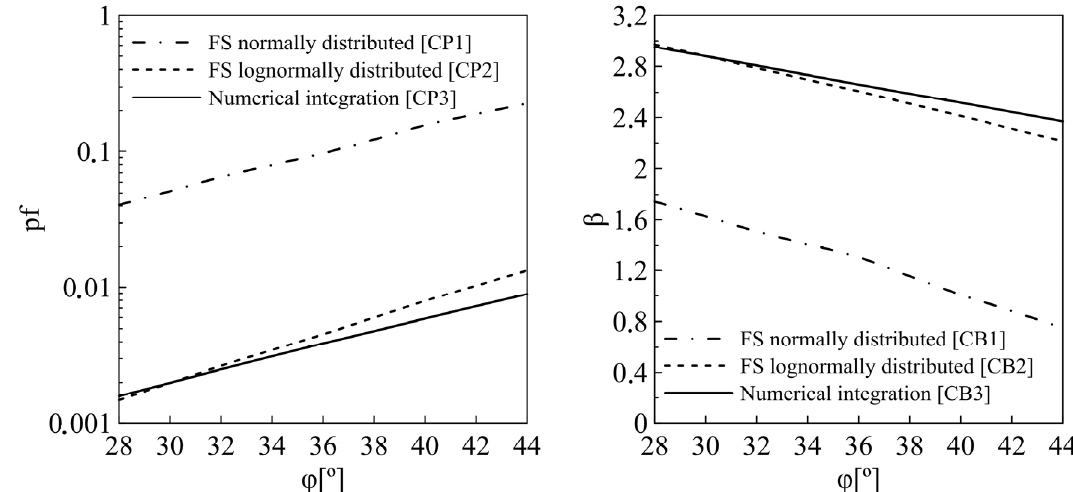
Figure 8. Comparison of pf and β calculated with the assumption that FS is normal and lognormal along with the results of Direct Integration of reliability integral.